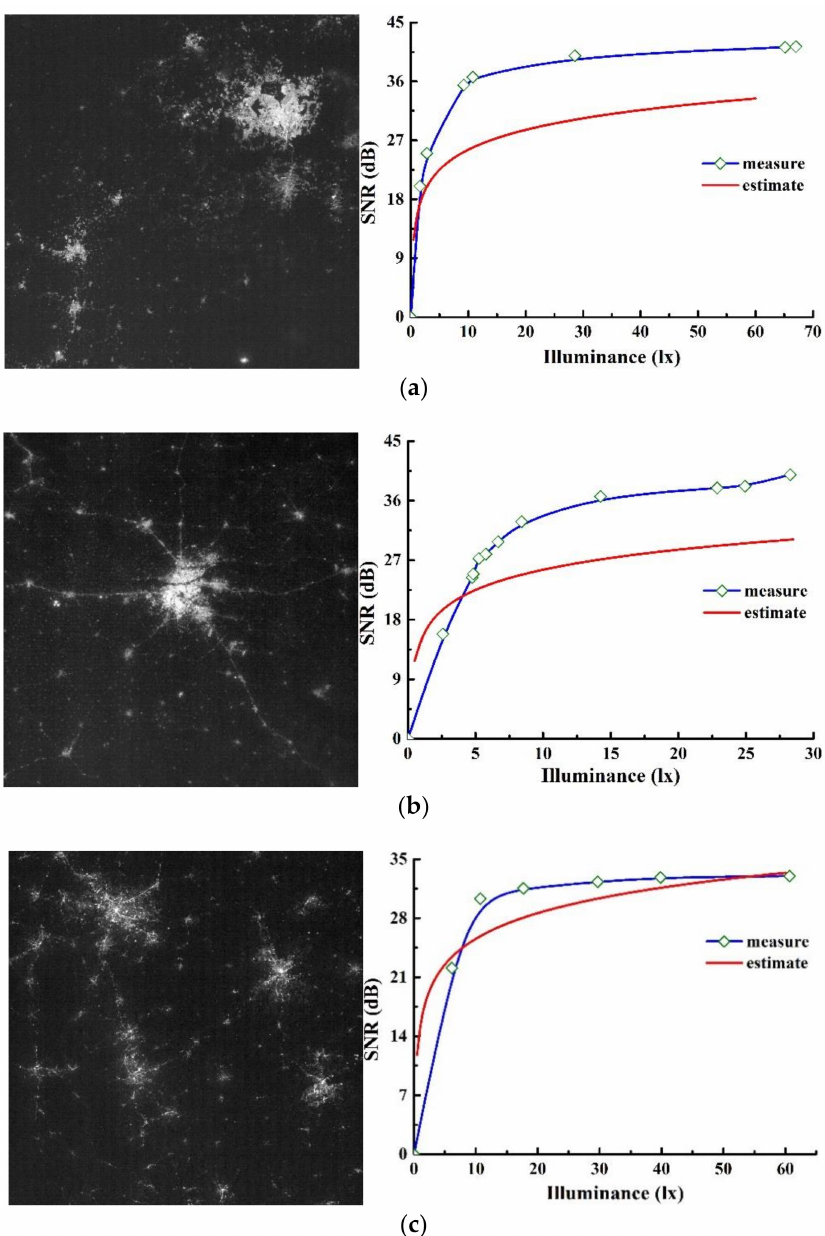
Figure 9. Night-light images and on-orbit test results of SNR based on time-sequence imagery of ( a ) Mexico City, ( b ) New Delhi, and ( c )